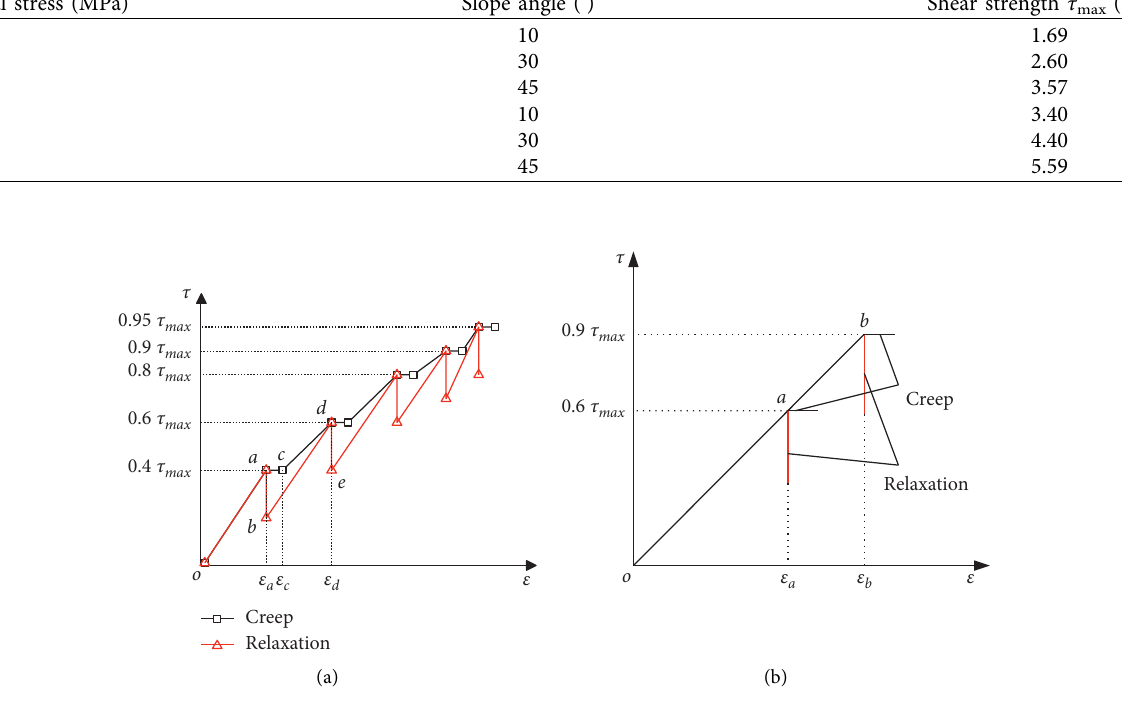
Figure 3: Schematic of the loading process: (a) step loading and (b) single loading.